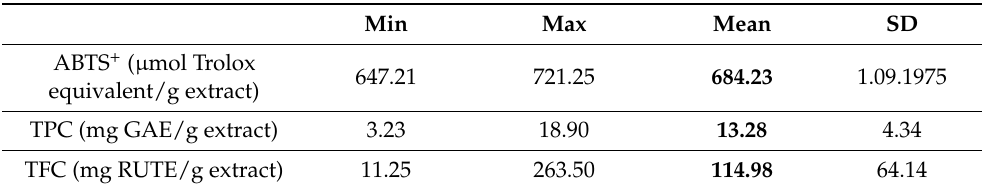
Table 1. The total phenolic content (TPC), total phenolic acid content (TAC), total flavonoid content (TFC), and ABTS + in the elderberry extracts. Min Max Mean ABTS + ( µ mol